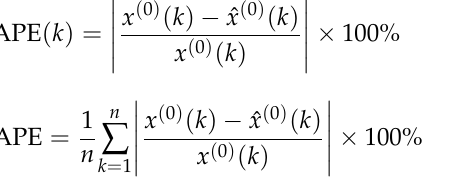
Table 2. Lewis’ benchmark of modeling accuracy evaluation.